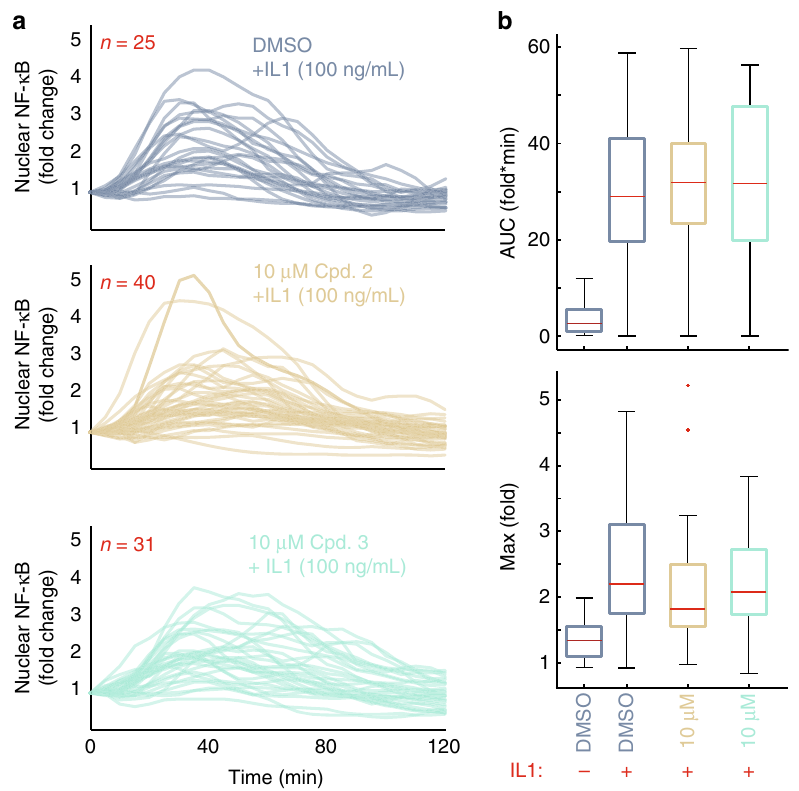
Fig. 4 Compounds do not alter dynamics of nuclear NF- κ B in response to IL-1. a Single-cell time courses of nuclear fl uorescent protein (FP)-RelA quanti fi ed in cells exposed to 100 ng/mL IL-1 in addition to either dimethyl sulfoxide (top, blue lines), 10 µ M compound 2 (middle, tan lines), or 10 µ M compound 3 (bottom, teal lines). Red numbers indicate the number of single-cell trajectories for each condition. b Box ( fi rst and third quartile) and whisker (1.5 times interquartile range) plots showing descriptors for the area under the fold change curve (top) and the maximum fold change of nuclear FP-RelA (bottom) for the indicated conditions and number of single-cell time courses measured from a do not show signi fi cant changes based on permutation tests (Supplementary Fig. 10). Red center line indicates the median, outliers marked with red dots; red minus and plus symbols, respectively, indicate the absence or presence of IL-1. Source data are provided as a Source Data fi